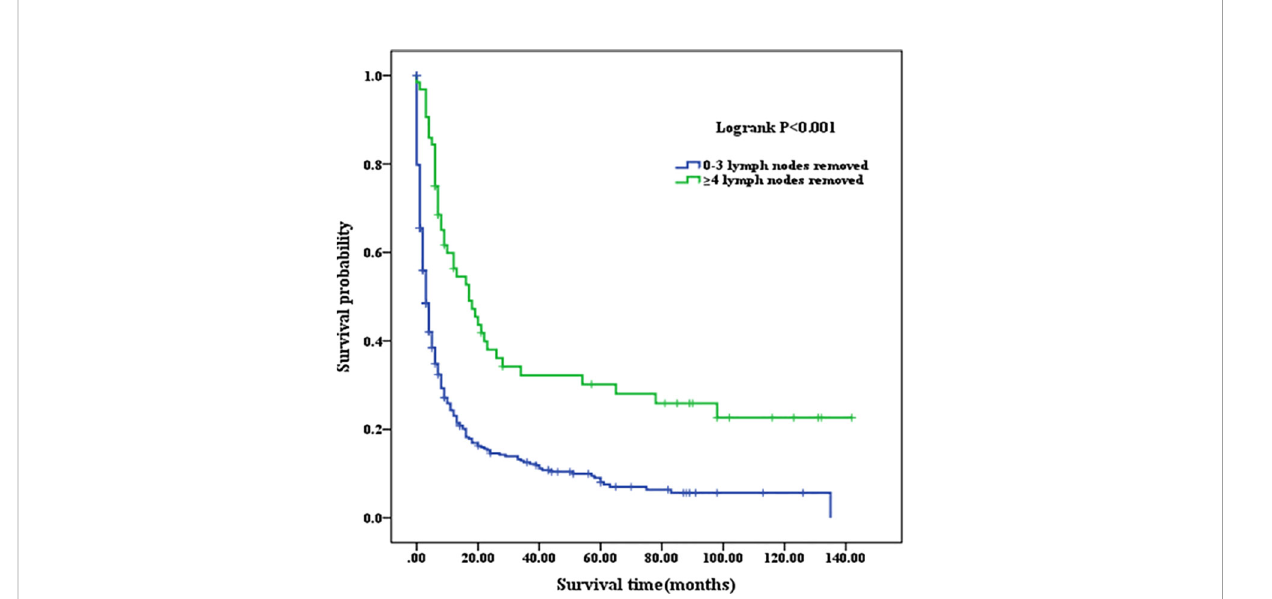
FIGURE 4 Kaplan – Meier analysis of survival curves strati fi ed by the number of lymph node removed in PSC cohort. PSC, pulmonary sarcomatoid